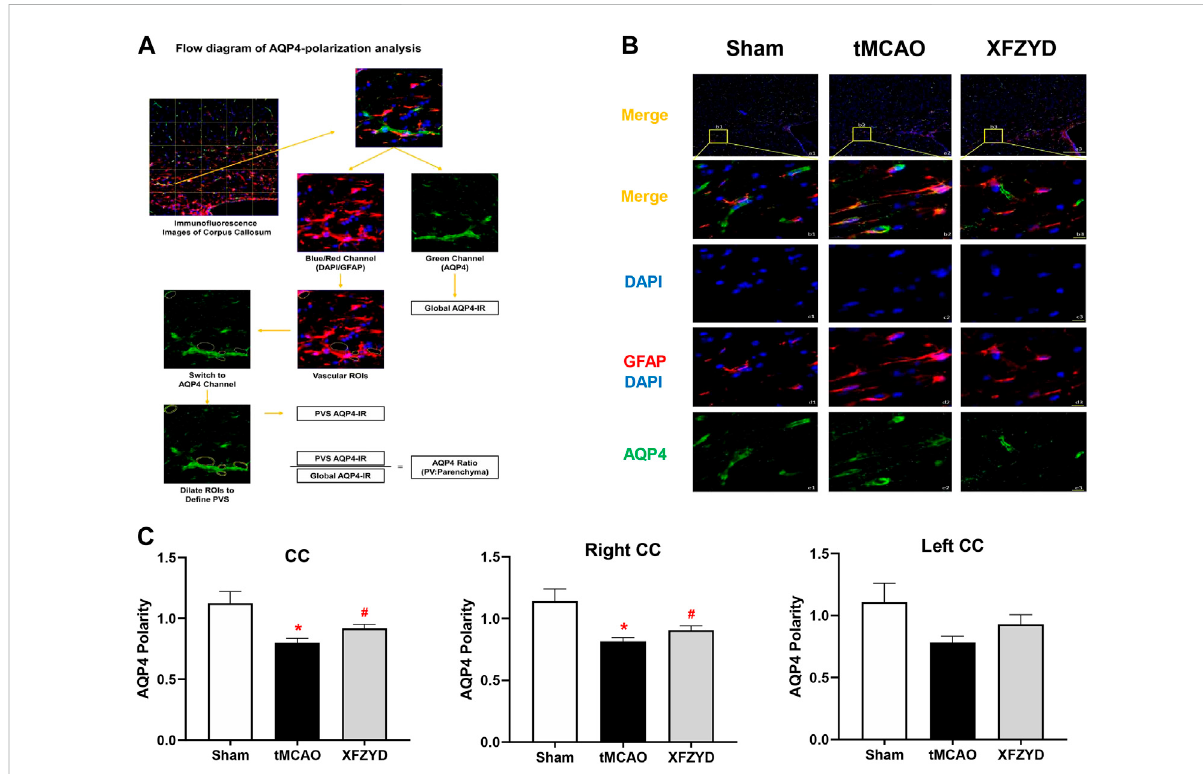
FIGURE 4 XFZYD restored AQP4 depolarization after tMCAO. (A) Flow diagram of AQP4-polarization analysis. (B) Representative images of AQP4 polarity in the CC. (a1-a3) Representative images showing the polarization of AQP4, GFAP and DAPI in different groups (green, AQP4; red, GFAP; blue, DAPI; scale bar, 200 μ m). (b1-b3) Enlarged views of a1-a3 (scale bar, 10 μ m). (c1-c3) The same regions but showing DAPI (scale bar, 10 μ m). (d1-d3) Same regions as for GFAP and DAPI but showing vascular ROIS (scale bar, 10 μ m). (e1-e3) AQP4 channels (scale bar, 10 μ m). (C) Quantitative analysis of AQP4 polarization in the whole CC, the left CC and right CC (* p < 0.05 vs. the sham group, # p < 0.05 vs. the tMCAO group; n = 15 in CC from six mice per group). CC, corpus